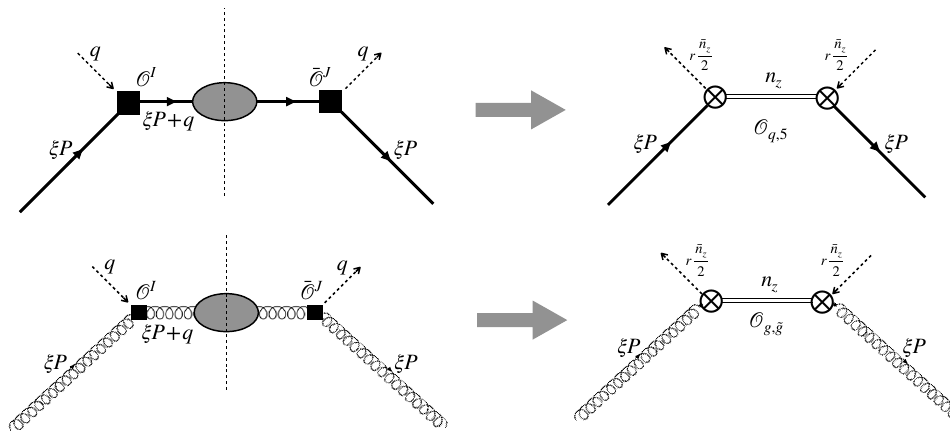
Figure 3 . Matching products of operators in hadronic tensor eq. (4.15) onto quark or gluon bilinear operators in eq. (4.18) or eq. (4.19) at tree level, using partonic matrix elements in external quark or gluon states with momentum ξP . The operators O I,J are the hadronic part of generic SM or SMEFT operators or amplitudes, and proton matrix elements of O quark and gluon PDFs in the proton, see eqs. (4.20) and